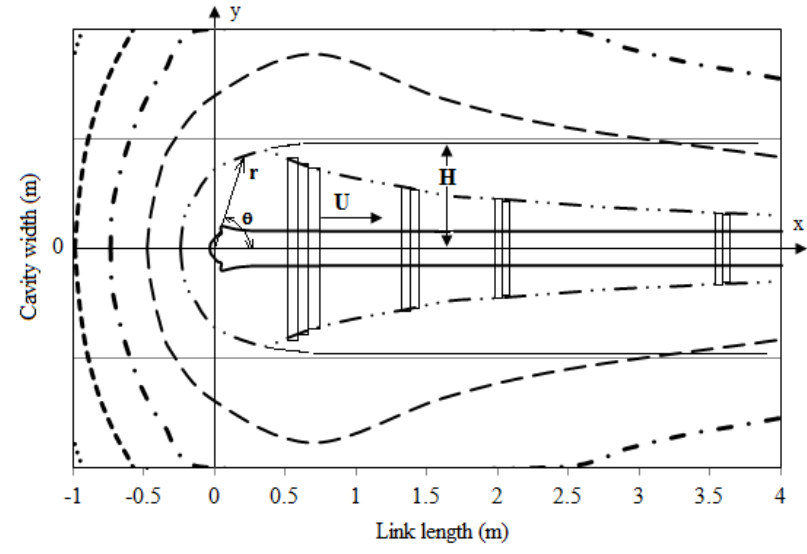
Figure 27. UCG cavity defined in the work of Luo et al. [58].